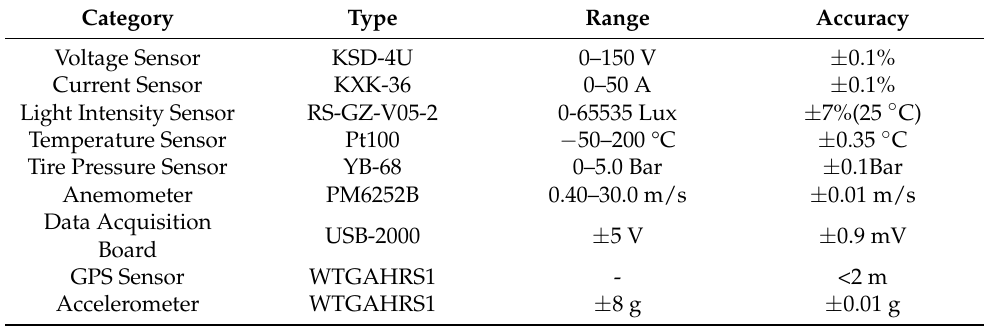
Table 3. Specifications of test